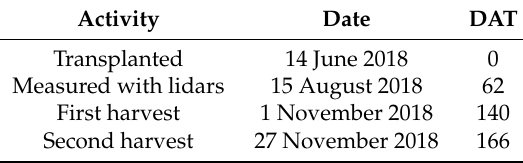
Table 1. Timeline of the measured crop, indicated in Days After Transplant (DAT).